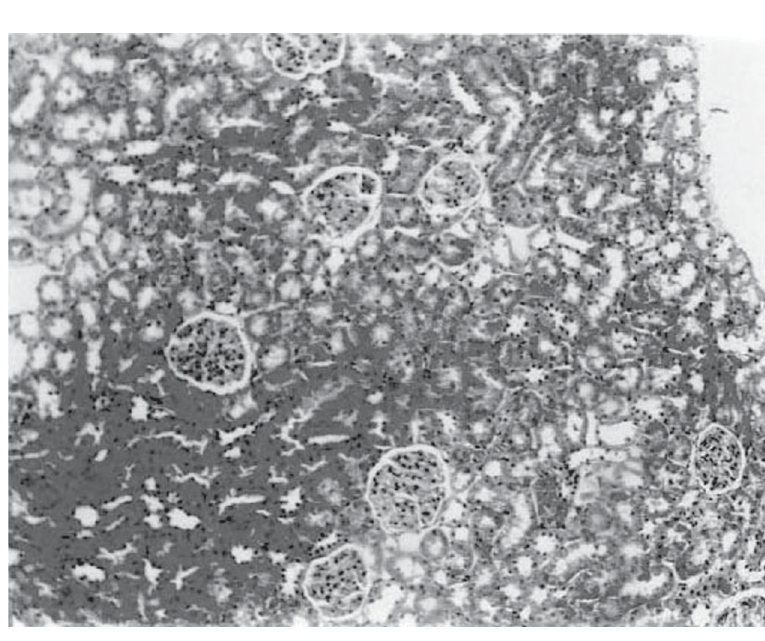
Figure 1. Histopathology of rat 3 (group I, simple ischemia). Note the absence of alterations in the nephrologic structure of the glomeruli, tubules, interstitium and vessels. There are no casts in the tubular lumina (HE,